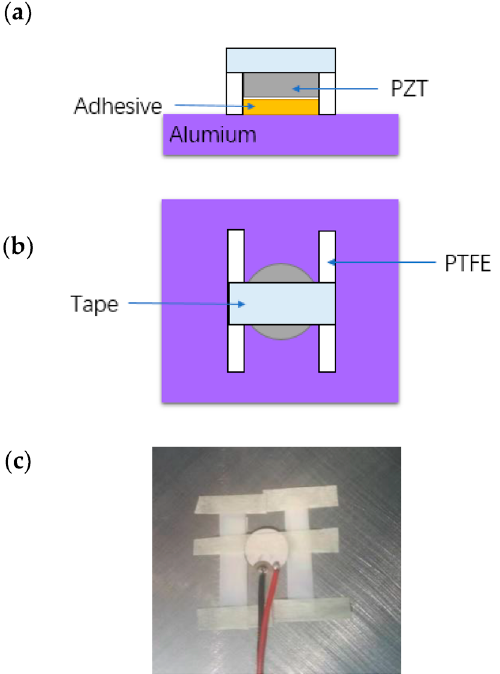
Figure 5. Control method of adhesive thickness: ( a ) positive view image; ( b ) top view image; ( c ) actual